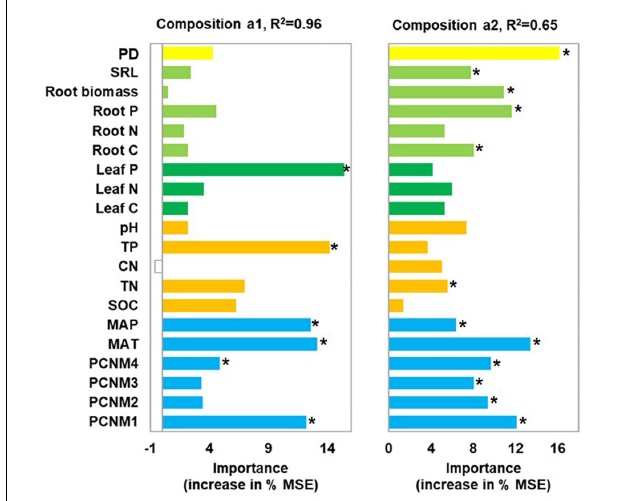
FIGURE 6 | Random forest analysis identifying best individual predictors of fungal community composition in nine forest ecosystems. MSE: mean square error. Community compositions a1 and a2 represent first and second NMDS axes. Compositional variation is represented by Bray-Curtis distance matrix at OTU level. * p <